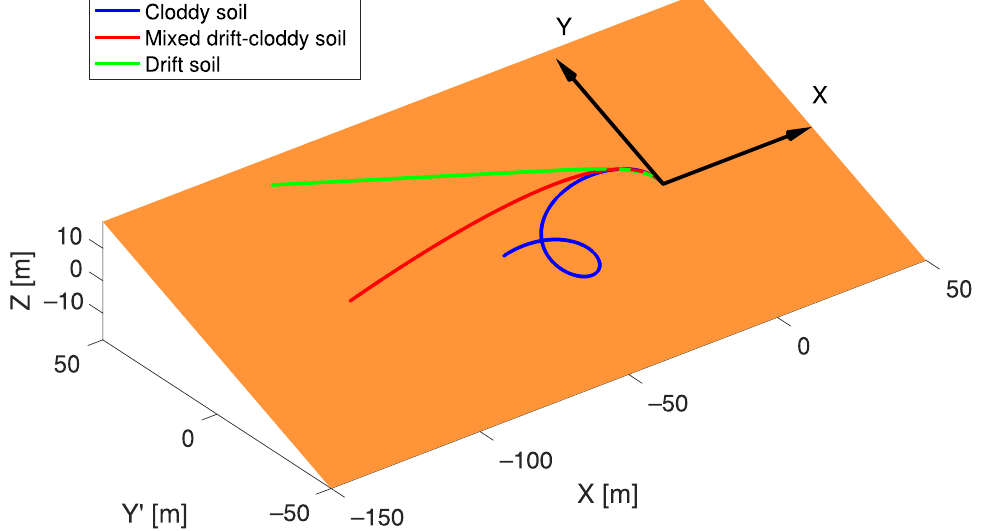
Figure 7. Rover’s trajectories in the 3D space on a 20° slope with constant steering angle 𝛿 = 4° and adaptive speed 𝑉̅ .